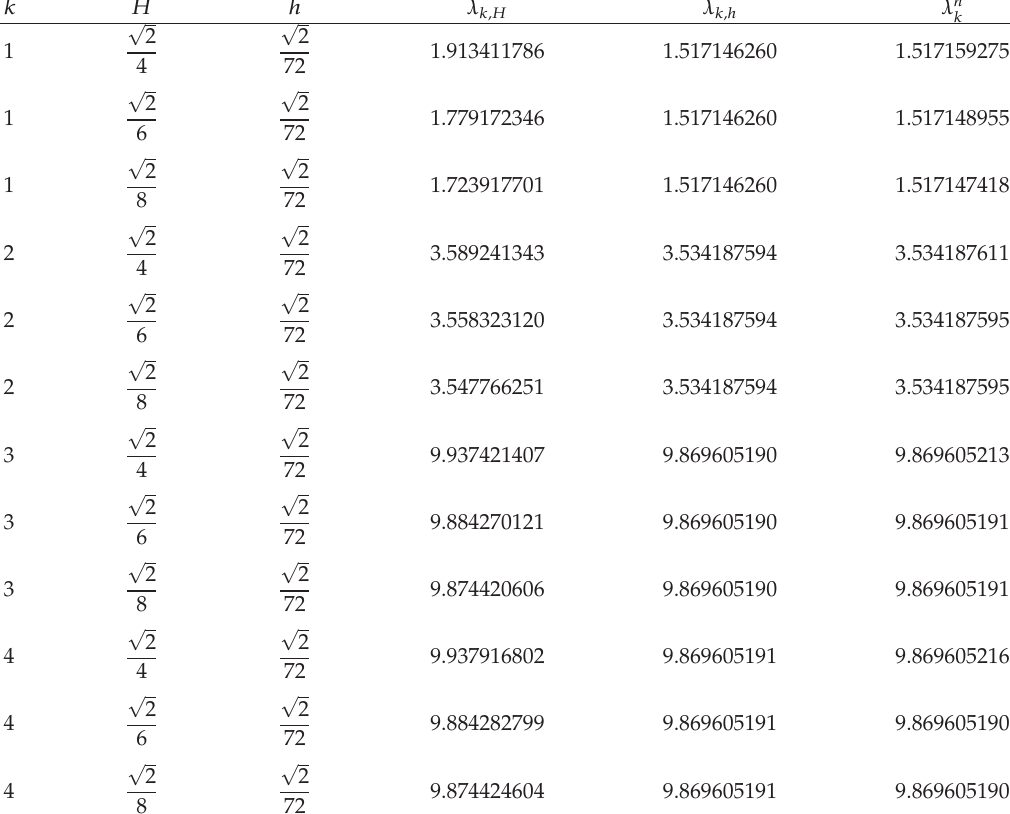
Table 4: The results on the L-shaped domain by Scheme 1 (cid:4) P 2 - P 1 element (cid:5) for eigenvalue problem of electric field (cid:4) r (cid:3) 0 . 95 (cid:5)